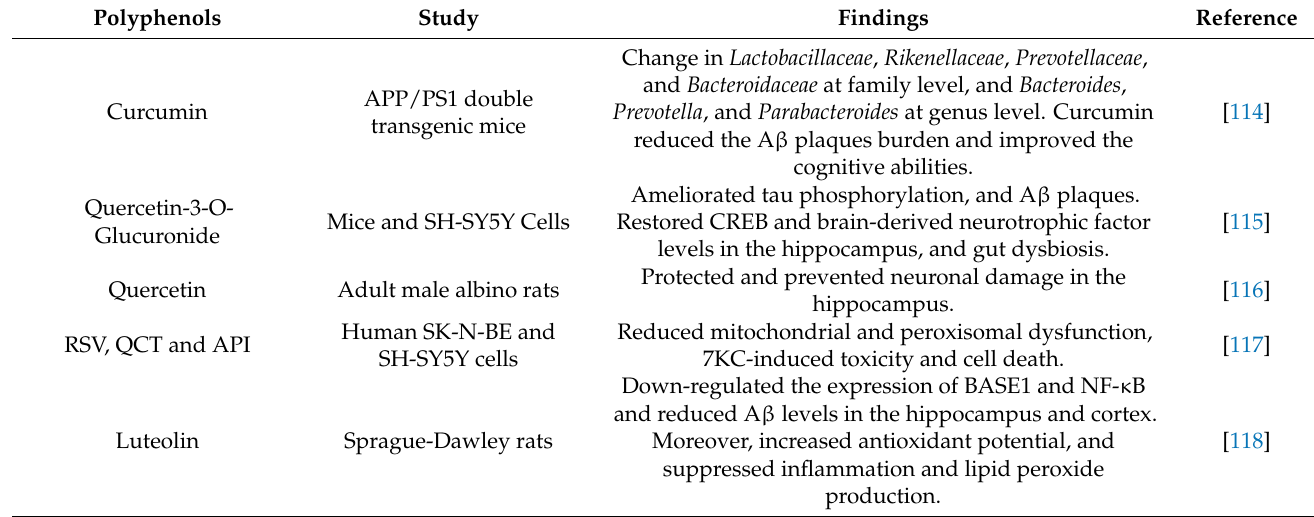
Table 3. Potential role of polyphenols in AD and related